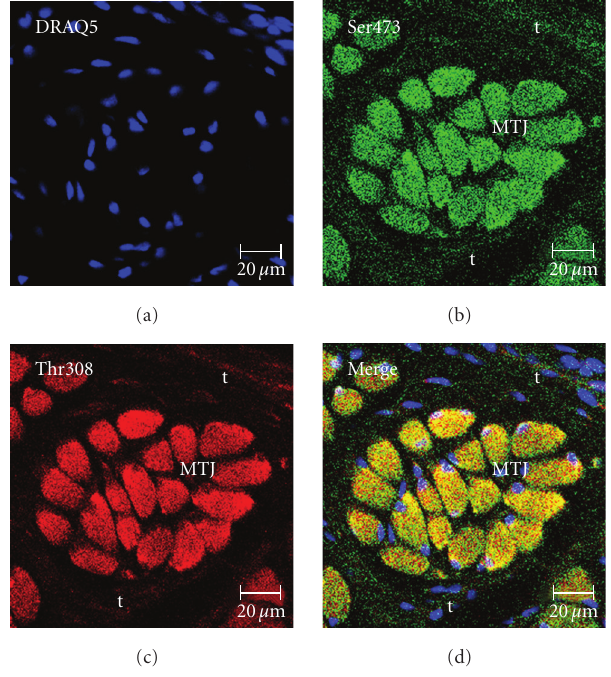
Figure 2: Immunofluorescence colocalization of Akt1/PKB α phosphorylated at Ser473 and at Thr308 in muscle fibers at the myotendinous areas. The nuclei in muscle fibers and tendocyte were visualized by staining of DNA with DRAQ5 (a, blue). The p-Akt1/PKB α Ser473 (b, green) was localized in across sectioned muscle fibers at the MTJ. In muscle fibers at the MTJ, p-Akt1/PKB α Thr308 (c, red) was identified. In same muscle fibers, p-Akt1/PKB α Ser473 and Thr308 were colocalized (d, yellow). The tendon cells were negative for localizations of Ser473 as well as of Thr308. MTJ = myotendinous junction, t = tendon. Bar: (a)–(d) = 20 μ